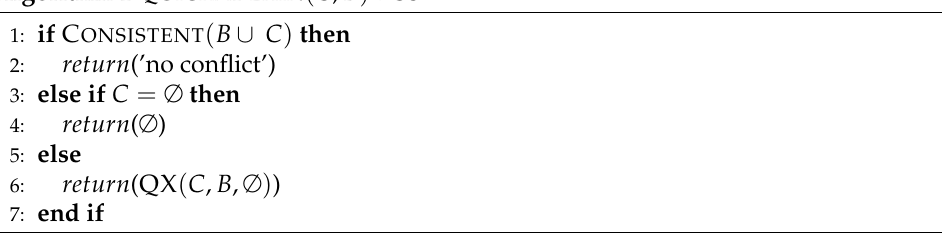
Algorithm 2 QX ( C = { c 1 .. c m } , B , B δ ) :